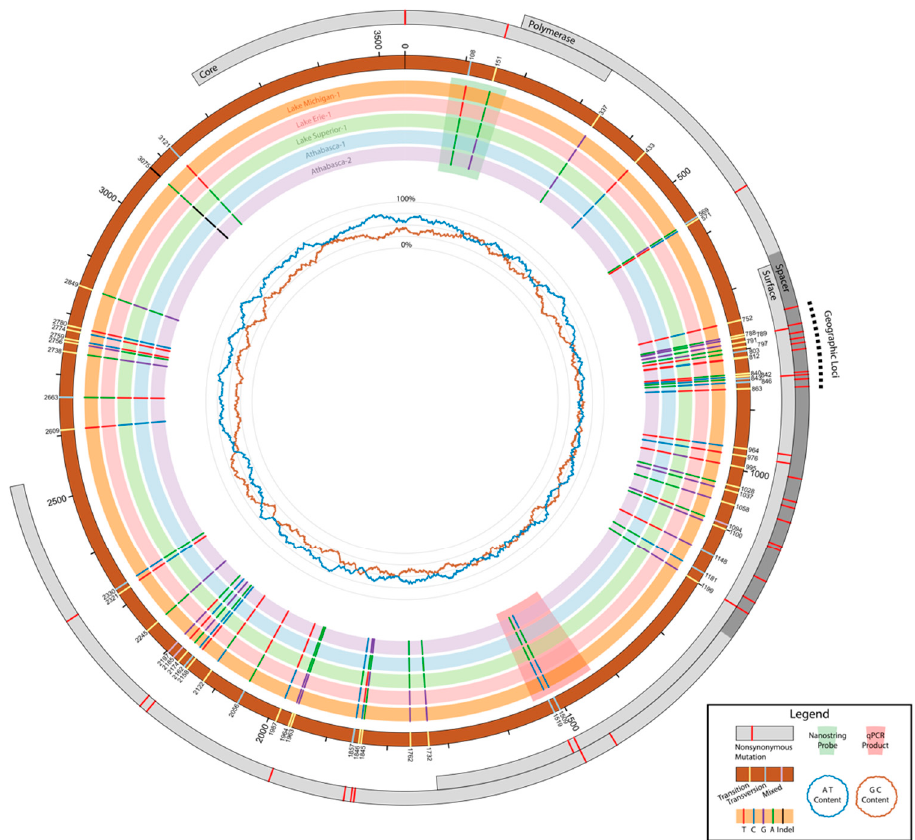
Figure 5. Polymorphic Sites across geographically structured haplotypes. The grey outer rings represent the protein-coding regions of white sucker hepatitis B virus (WSHBV) and are highlighted with nonsynonymous mutations. These mutations correspond with the single-nucleotide polymorphisms (SNPs) highlighted by the inner rings, which are representative of geographic sampling site. Small numbering around the positional reference ring also corresponds with these SNPs and shows whether changes are transitions or transversions. The inner most rings representing GC and AT content are on a scale of 0–100% (innermost to outermost).